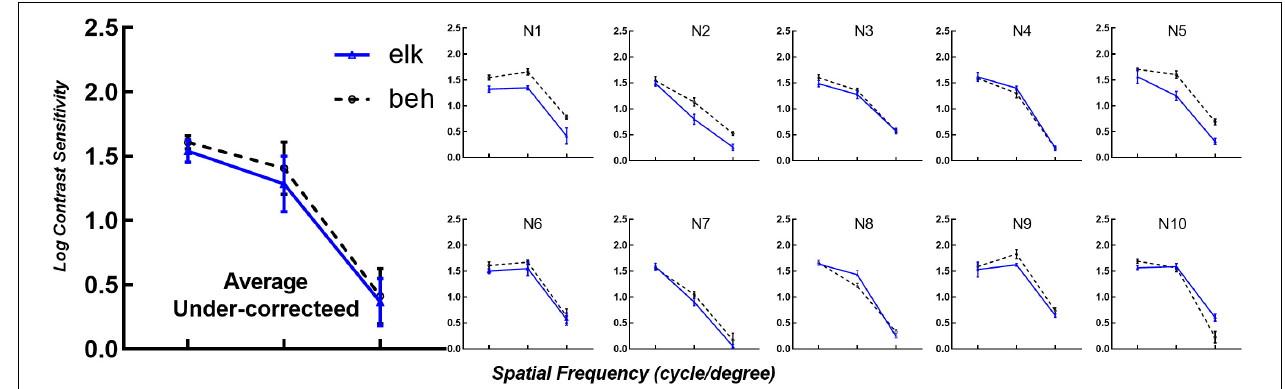
FIGURE 5 | LogCS measured with the two methods with visual acuity reduced to logMAR 0.20. The mean logCS of the eye tracking and behavioral tests of all participants with under-corrected visual acuities for each spatial frequency is shown in the first subplot (Average Under-corrected). The layout and icons are identical to Figure 2 . elk, eye tracking test; beh, behavioral test (conventional perceptual report).